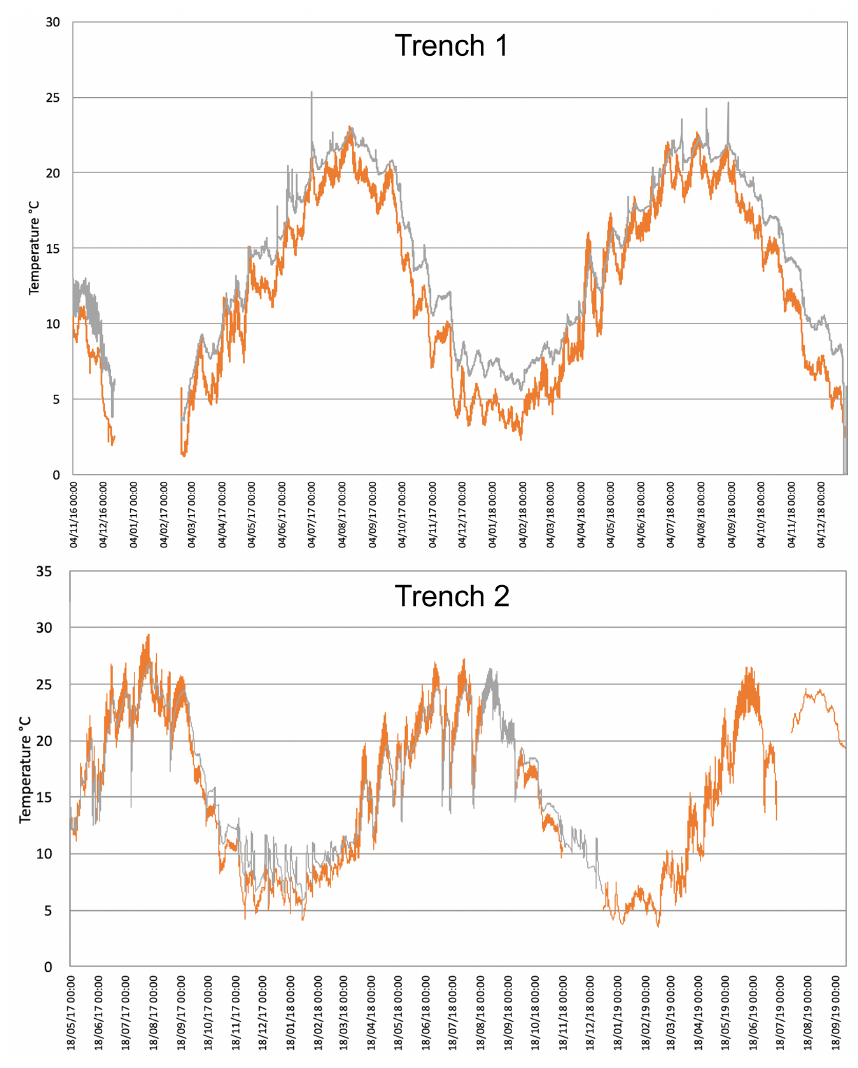
Figure 9. Temperatures recorded at Trench 1 from November 2016 to December 2018 and at Trench 2 from May 2017 to September 2019. The grey line represents the variations in temperature of the extensometer wire, inside the instrument, whereas the orange line shows tem- perature variations at the data logger that is near the ground surface (time zone: